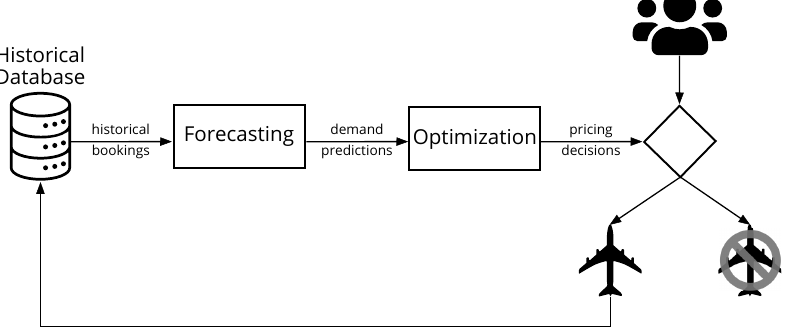
Figure 1. Inside revenue management